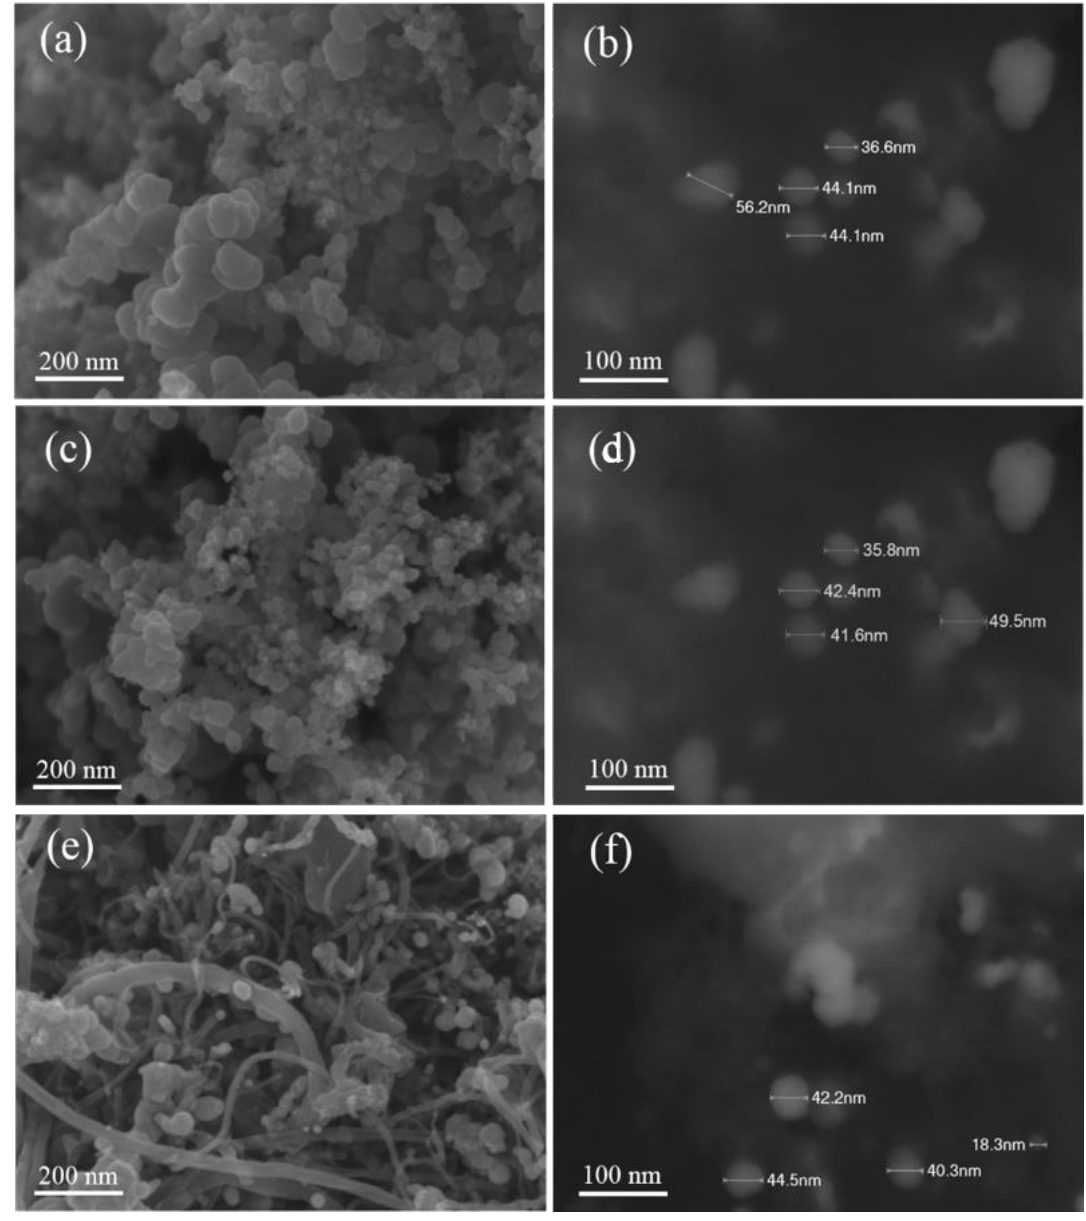
Figure 4. SEM images: ( a ) secondary electron image (SEI) and ( b ) composition (COMPO) mode for Ag / acetylene carbon (AC); ( c ) SEI and ( d ) COMPO mode for Ag / carbon black (CB); ( e ) SEI and ( f ) COMPO mode for Ag / multiwalled carbon nanotube (MWCNT).